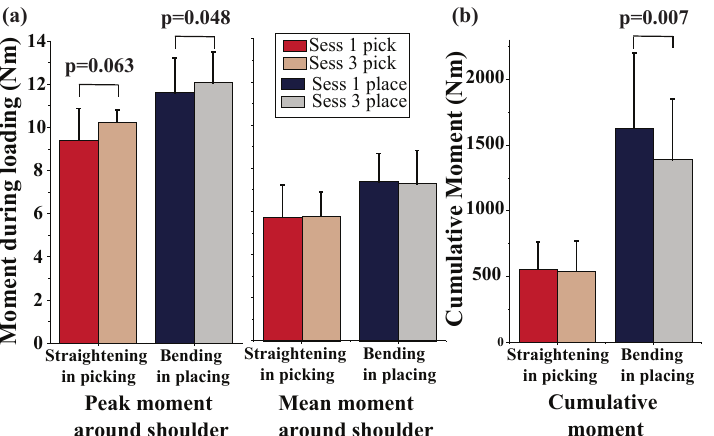
Figure 8. ( a ) The peak and mean moment and ( b ) the cumulative moment during the two loaded events are compared between the first and last